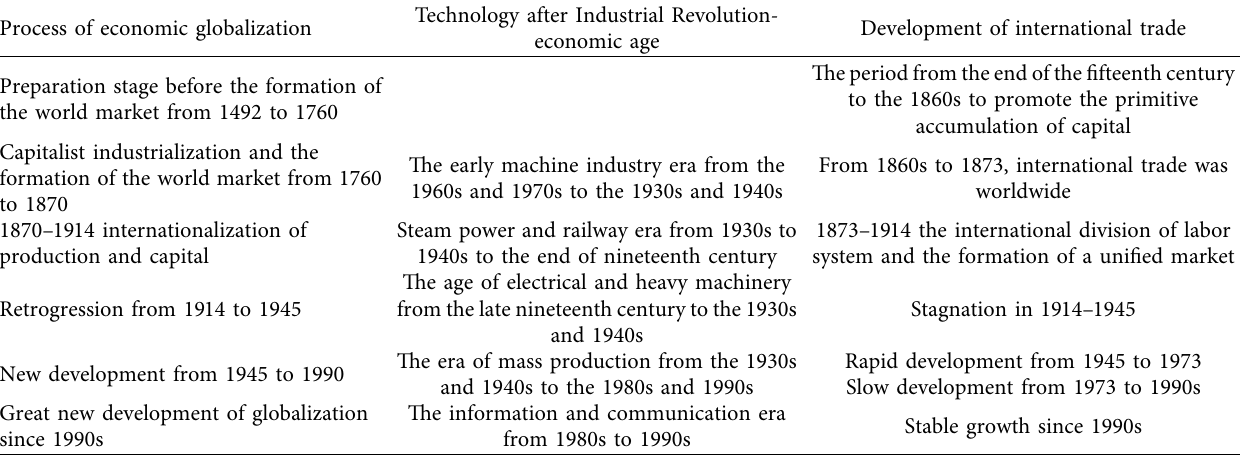
Table 1: Development stages of world economy and international